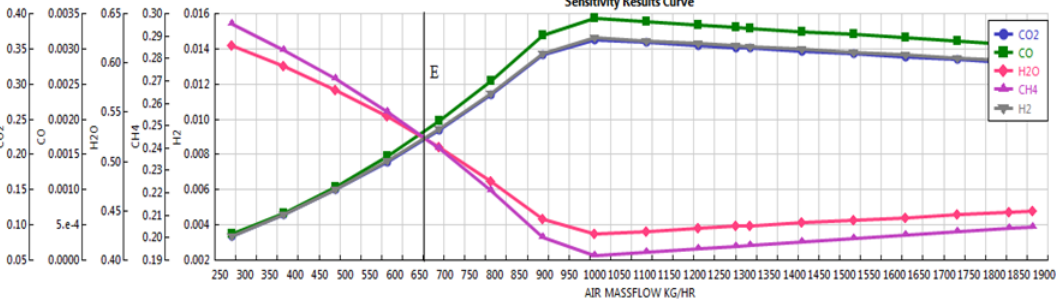
Figure 5. SMR sensitivity results (SMR molar fractions vs. Furnace Air mass flow rate). Line E corresponds to the Air flow rate of 650 kg/h.